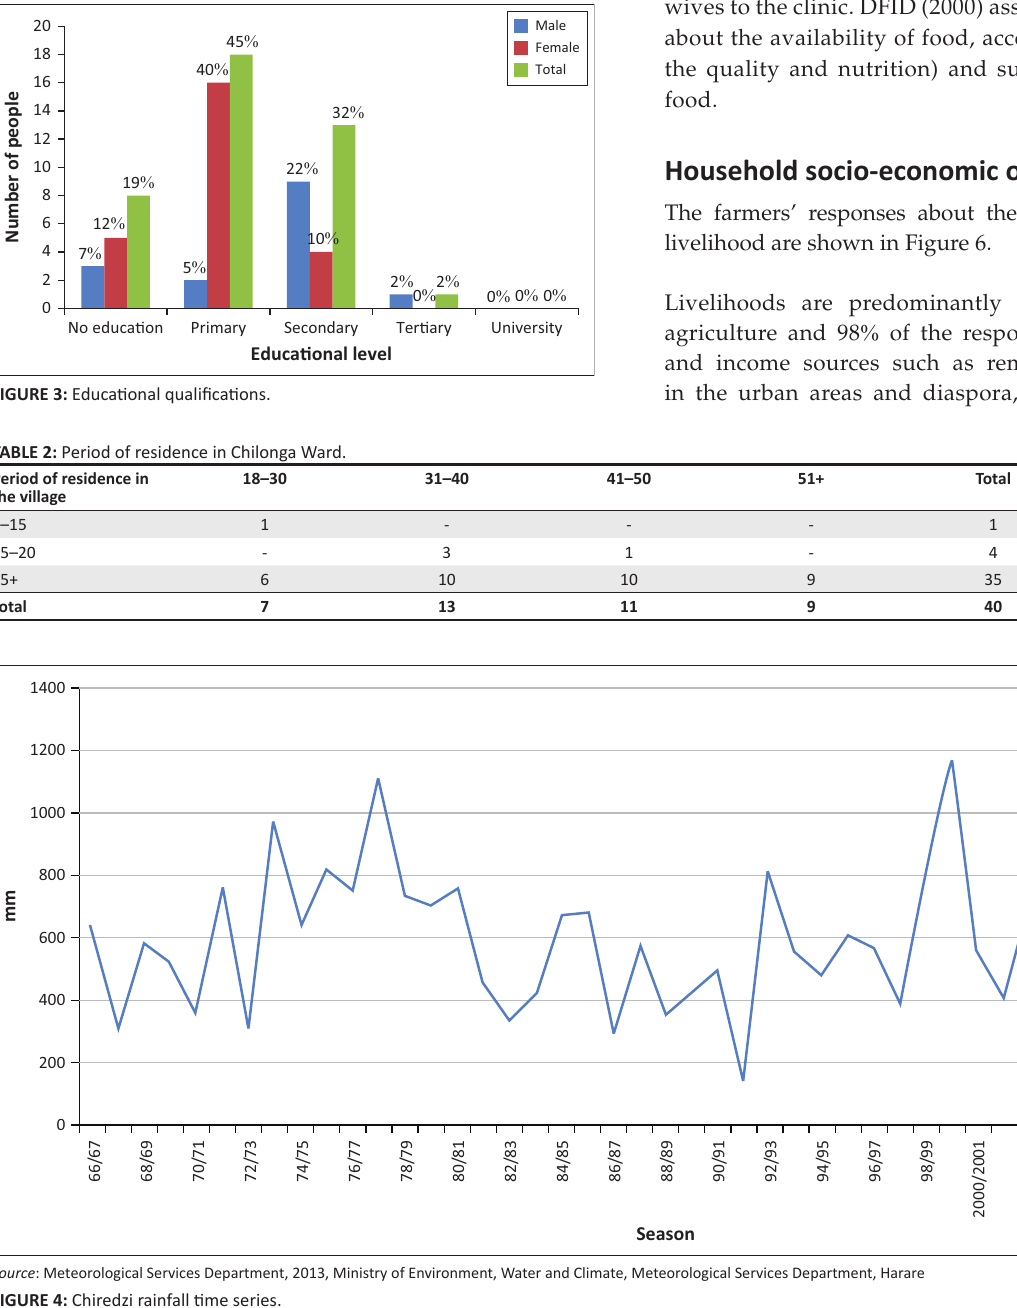
FIGURE 4: Chiredzi rainfall time series.